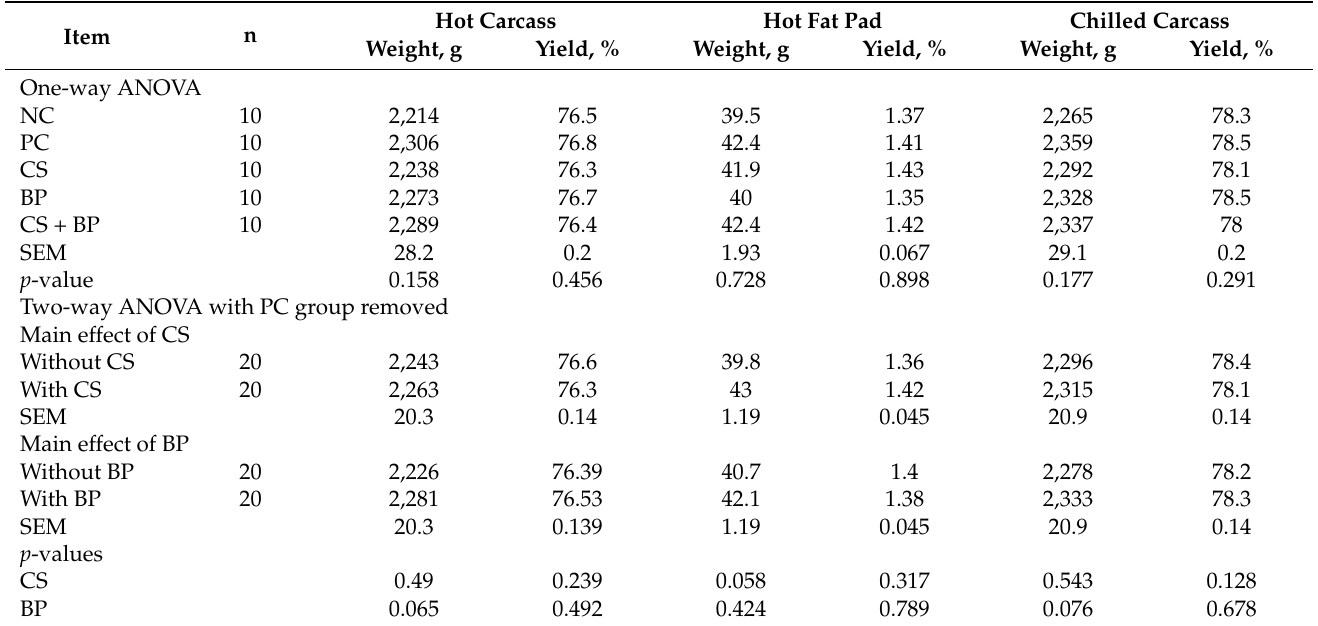
Table 5. Carcass characteristics of broilers fed diets with and without bacitracin methylene disalicylate or various antibiotic alternatives from 0 to 47 d post-hatch and processed at 48 d post-hatch 1